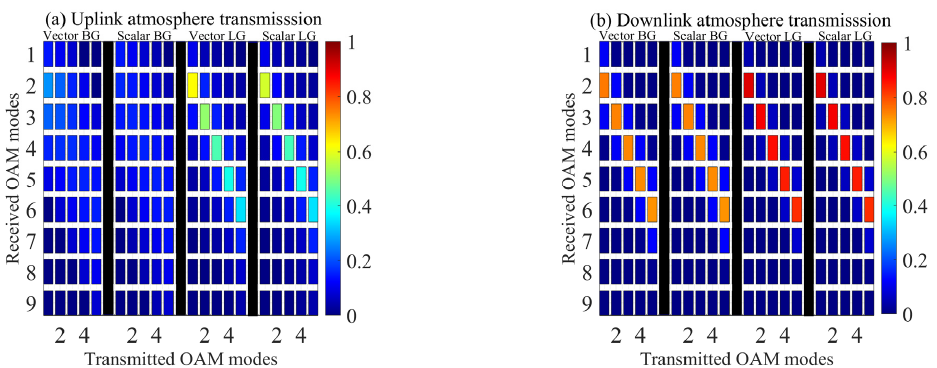
Figure 5. OAM spectrum of vector and scalar vortex beams for uplink ( a ) and downlink ( b ) OAM communication system.